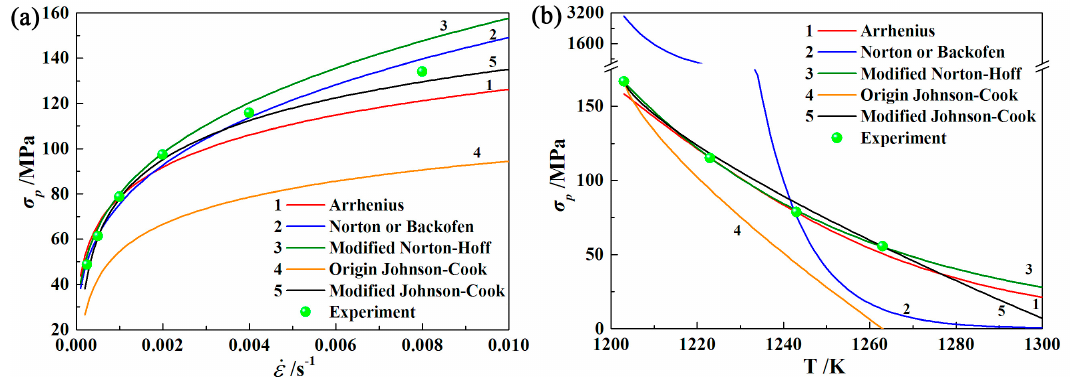
Figure 9. Variation of the peak stress of each constitutive model: ( a ) different strain rates and T = 970 ◦ C; ( b ) different temperatures and . ε = 1.0 × 10 − 3 s − 1 .